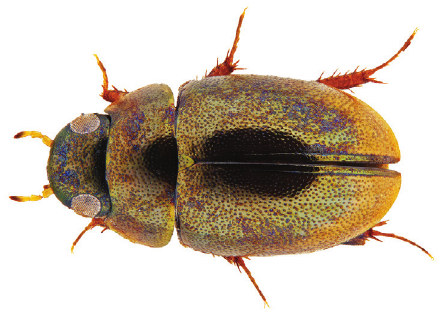
Figure 20. Paracymus exiguus Wooldridge, 1977 2.5 mm, iSimangaliso Wetland Park, False Bay (site 29), February 2015 DT Bilton, MS Bird & R Perissinotto leg.